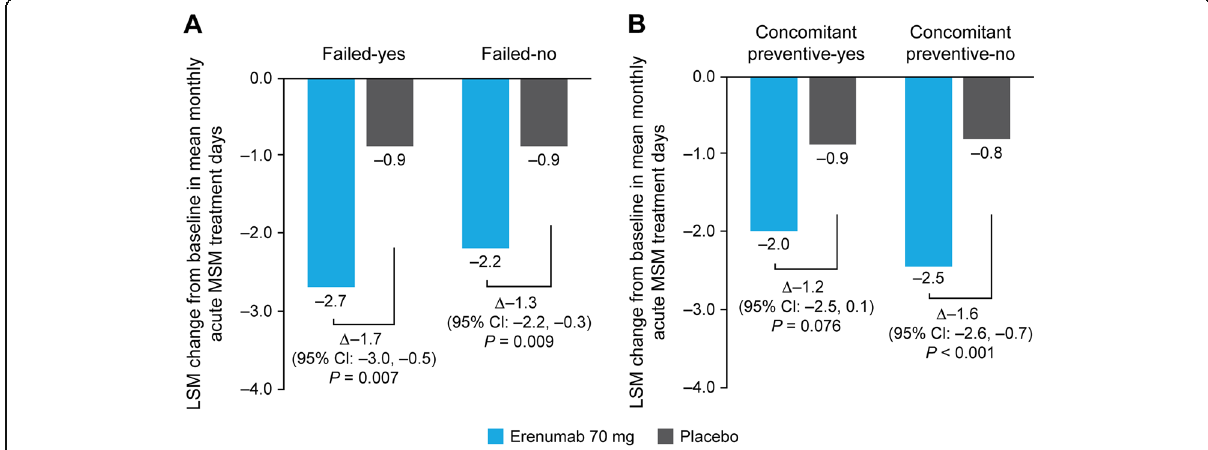
Fig. 3 LSM change from baseline in mean monthly acute MSM treatment days in ( A ) failed-yes/no and ( B ) concomitant preventive-yes/no subgroups. CI confidence interval, LSM least squares mean, MSM migraine-specific